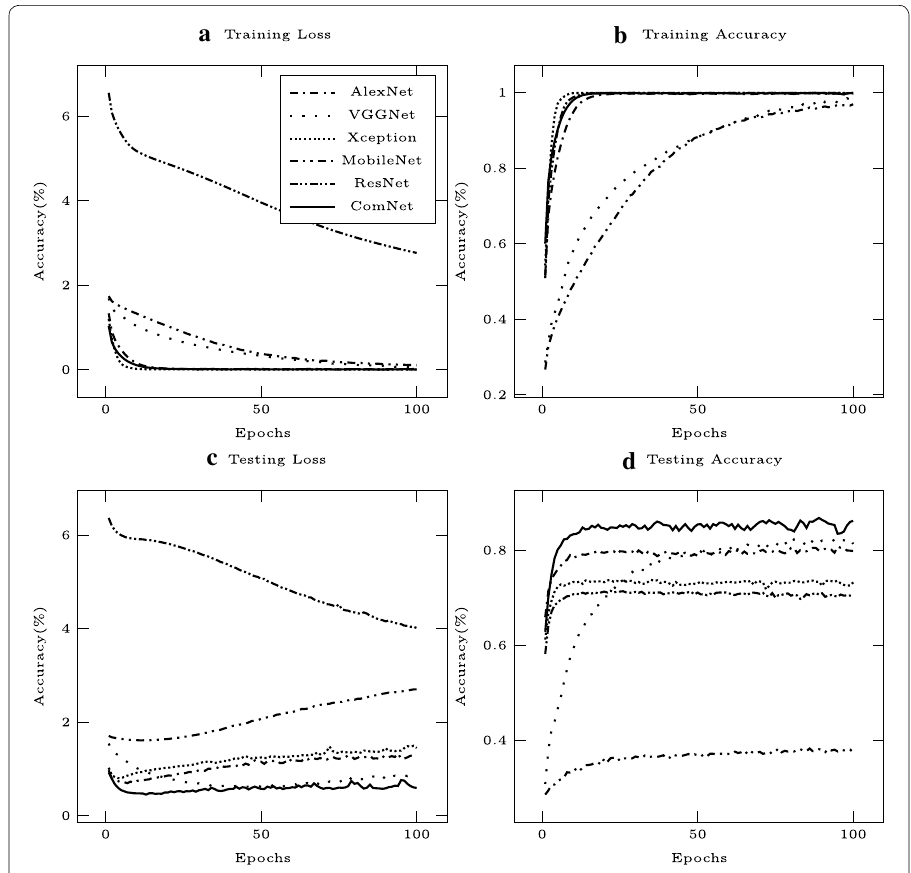
Fig. 14 Progression of a Training loss, b Training accuracy, c Testing Loss, and d Testing Accuracy for all DCNN architectures on Tea. The results are the average values of 10-fold cross